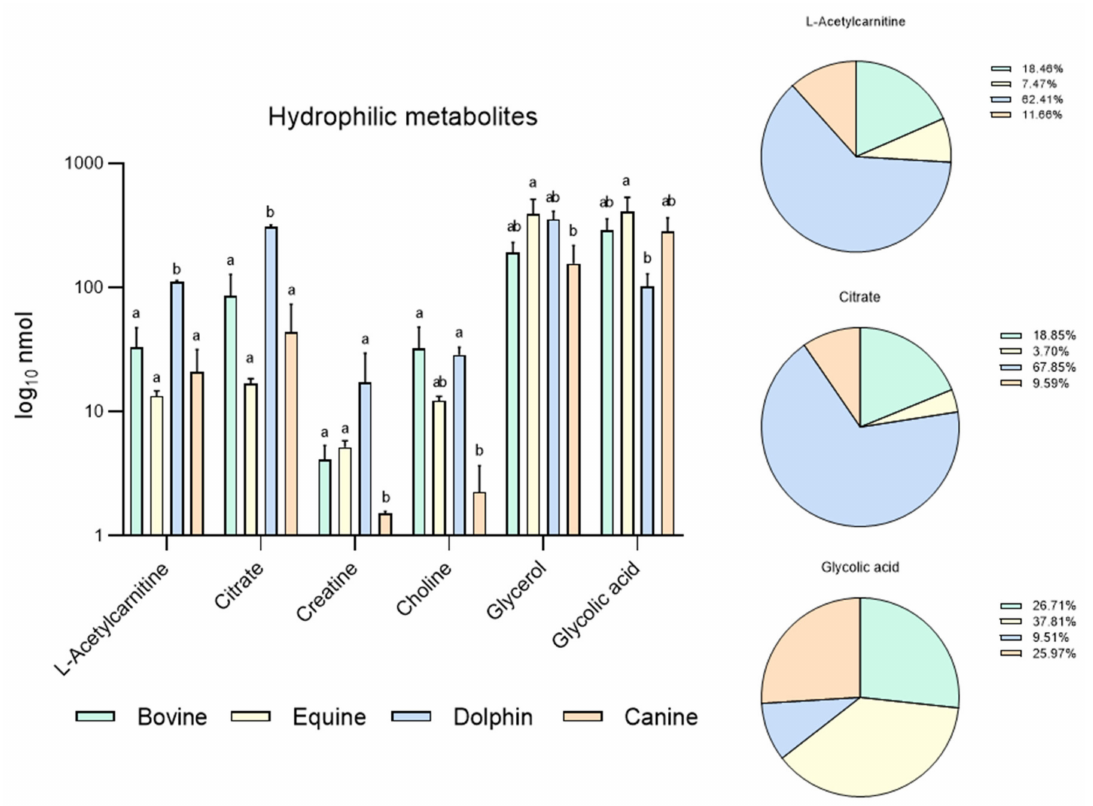
Figure 1. Metabolites identified in bovine, equine, dolphin and canine sperm showing differences between species in 16 metabolites identified in the hydrophilic phase of sperm extracts by NMR spectroscopy. a,b Different letters indicate significant differences ( p < 0.05) among species for each metabolite. Bovine and dolphin data were already published [60], equine and canine data belong to this new